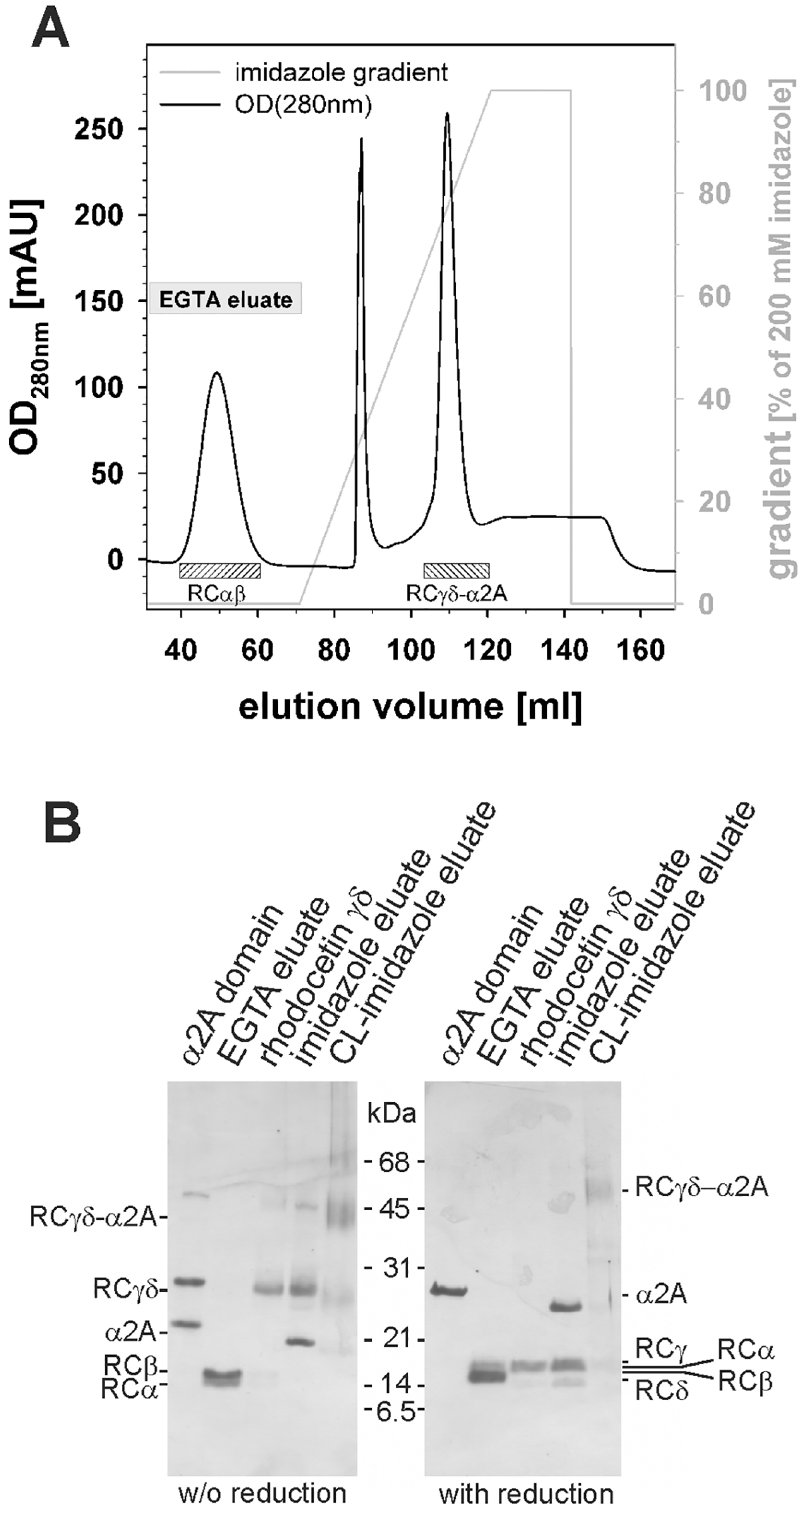
Fig 1. Isolation of the rhodocetin γδ - α 2Acomplex on Ni Sepharose column. (A) Elution profile of the Ni Sepharose affinity chromatography column. The RC γδ - α 2A complexwas formed on a Ni Sepharosecolumn by subsequently loadingthe oligo His-tagged α 2A domainand RC αβγδ .RC αβ and the RC γδ - α